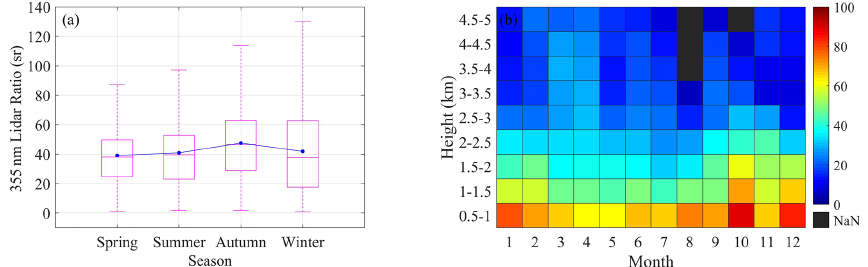
Figure 4. LR temporal variations. (a) Seasonal variations in LR. The blue dots are the average for each season. (b) The average of LR at different altitudes in different months. The black areas indicate an invalid value.